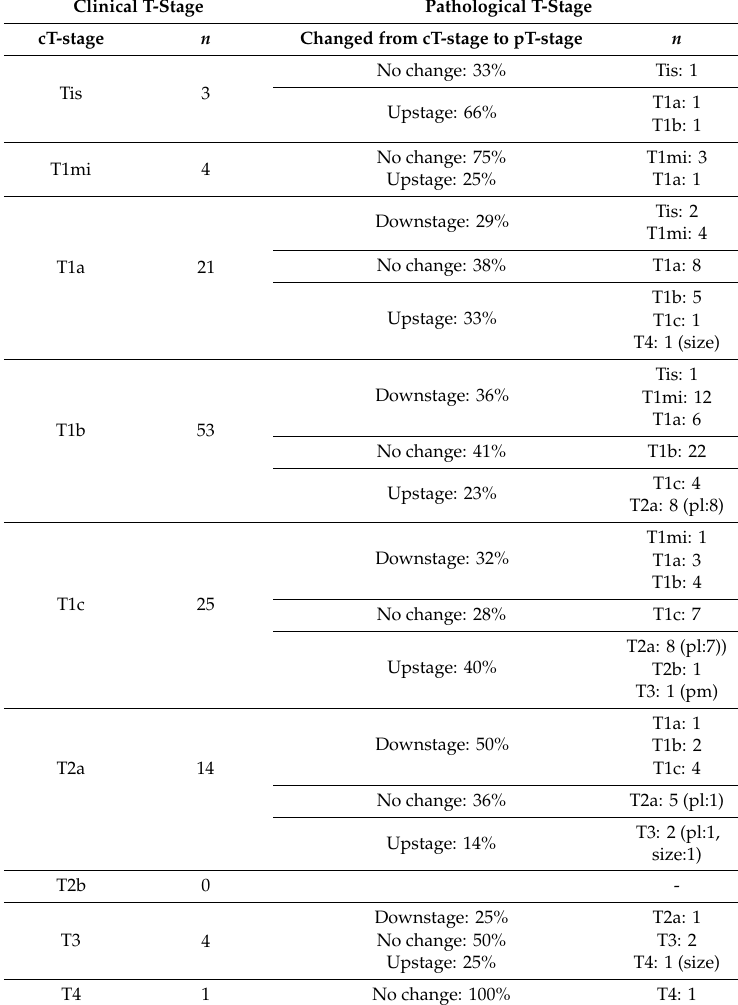
Table 7. Number of cases changed from clinical T-stage to pathological T-stage in 125